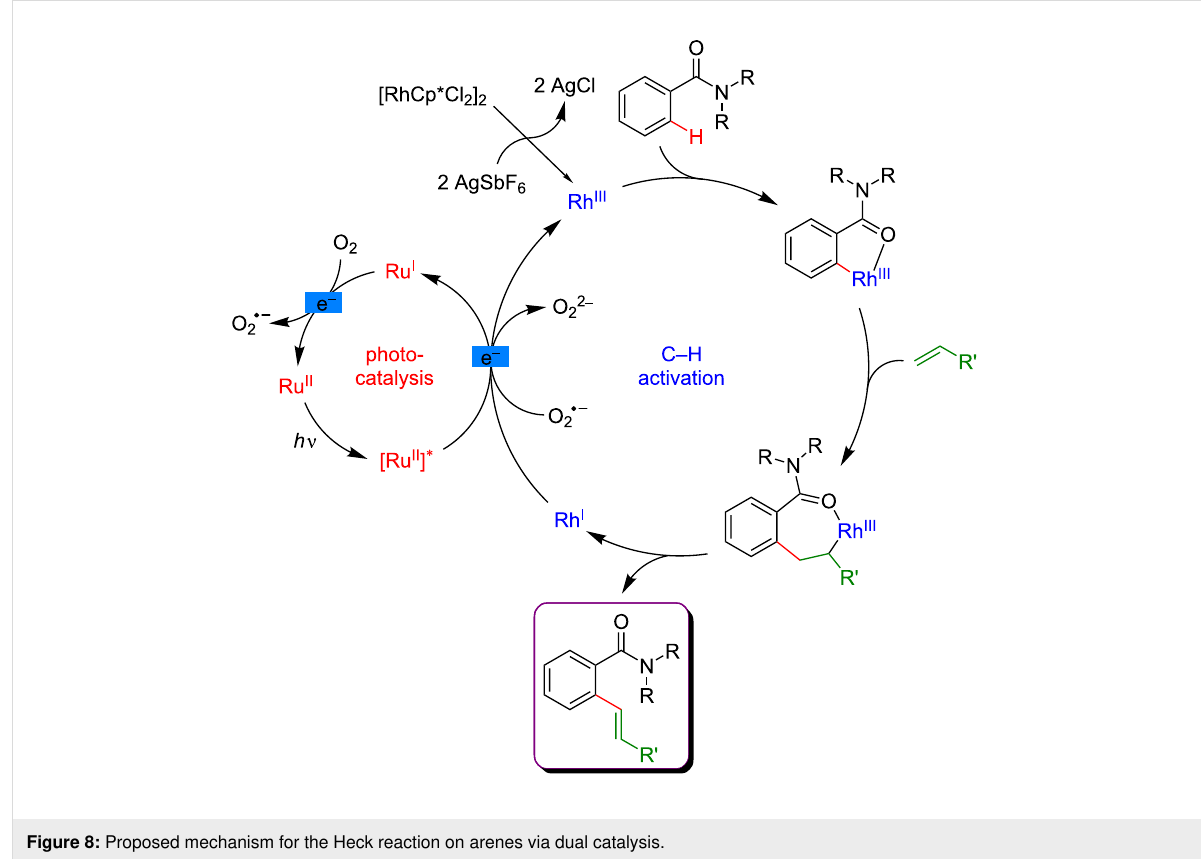
Figure 8: Proposed mechanism for the Heck reaction on arenes via dual catalysis.